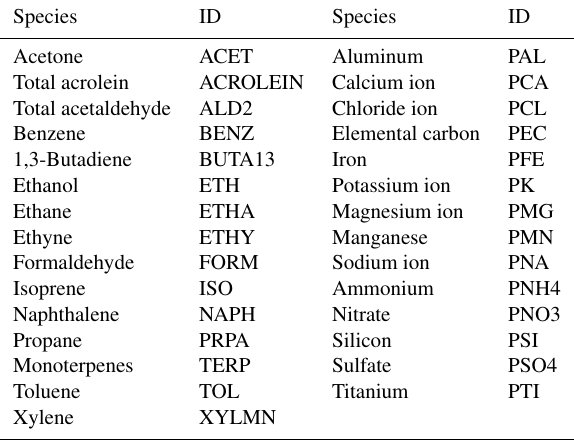
Table 1. List of chemical species included in the BRAVES database (Yarwood et al.,